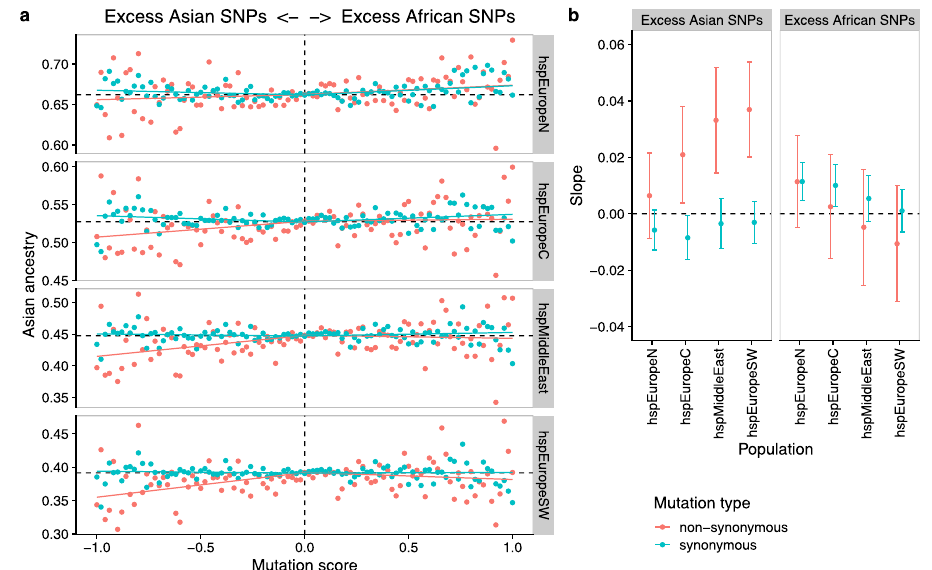
Fig.3|GeneticancestryofhpEuropesubpopulationsasafunctionofmutation score. a Average ancestry in chromosome painting analyses plotted against mutation score (mutation frequency in African populations minus mutation frequency in Asian populations) in bins of 0.02. Regression lines were cal- culated separately for positive and negative mutation scores from the